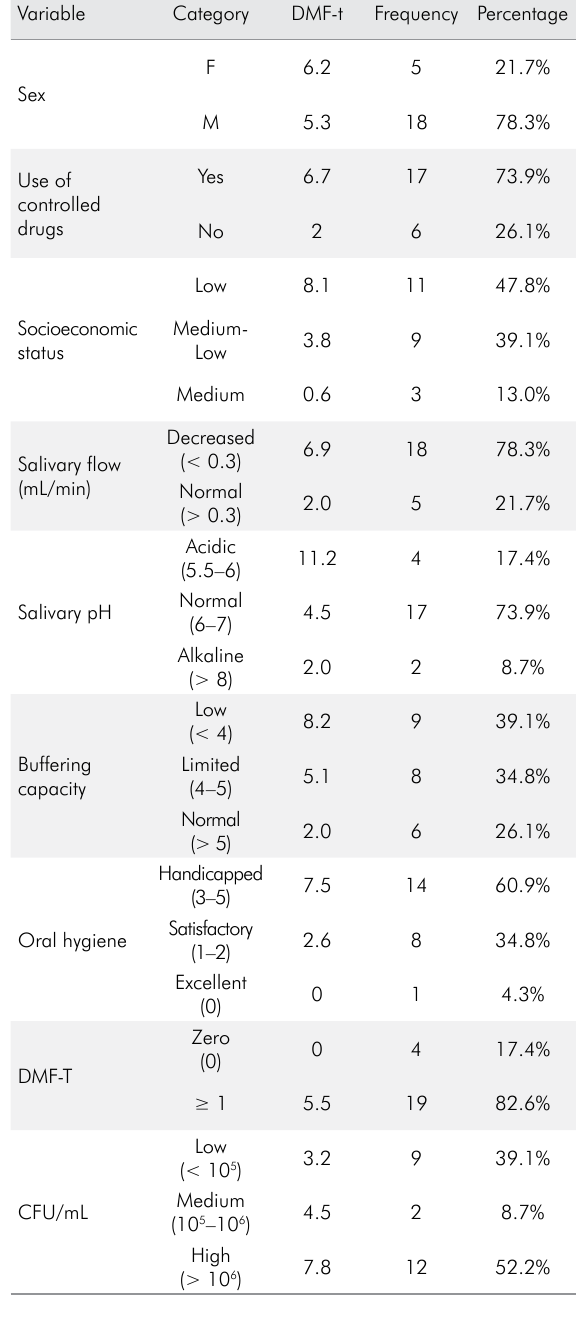
Table 2. Distribution and description of the sample according to caries experience and studied variables of individuals with FXS.